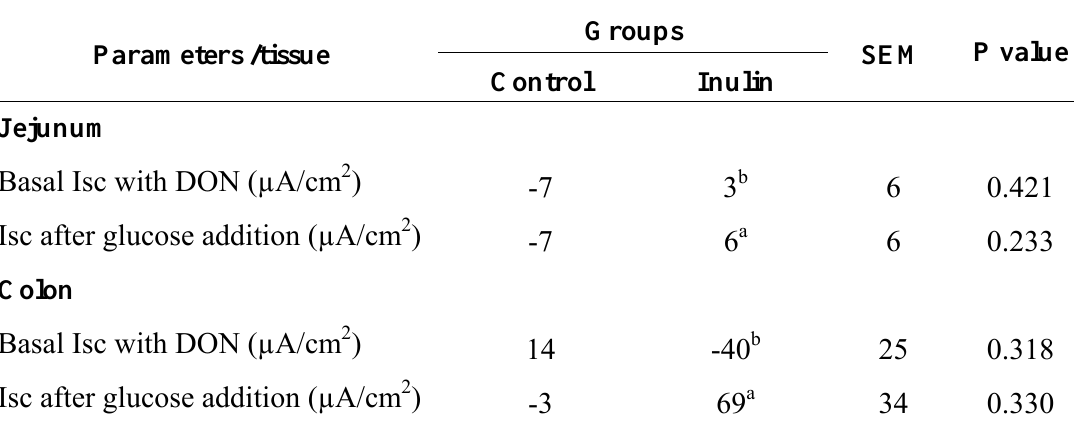
Table 4. Short-circuit current (Isc) across the isolated jejunal and colonic mucosa of broilers after preincubation of the tissues with DON and after glucose